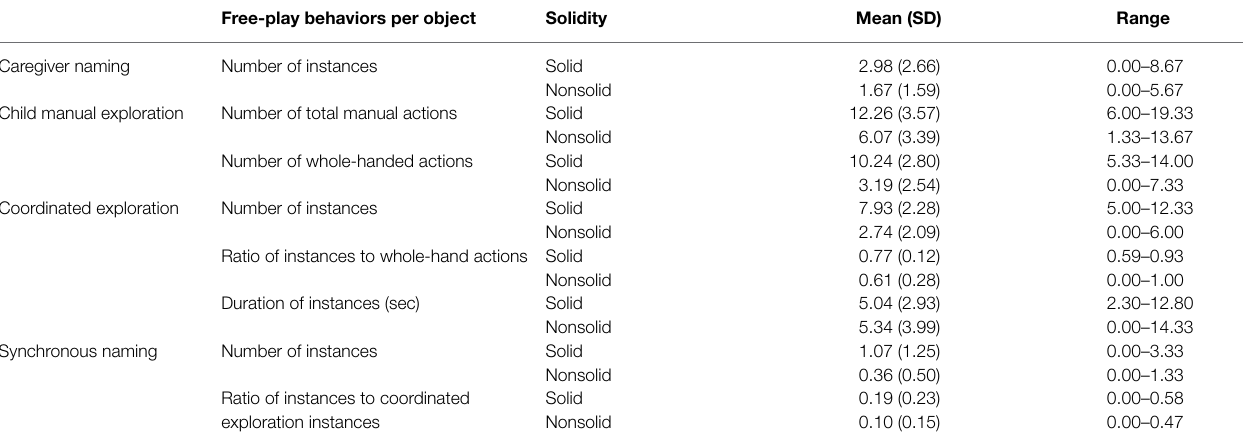
TABLE 1 | Descriptive statistics of free-play behaviors (based on each dyad’s average per object of each solidity type). Free-play behaviors per